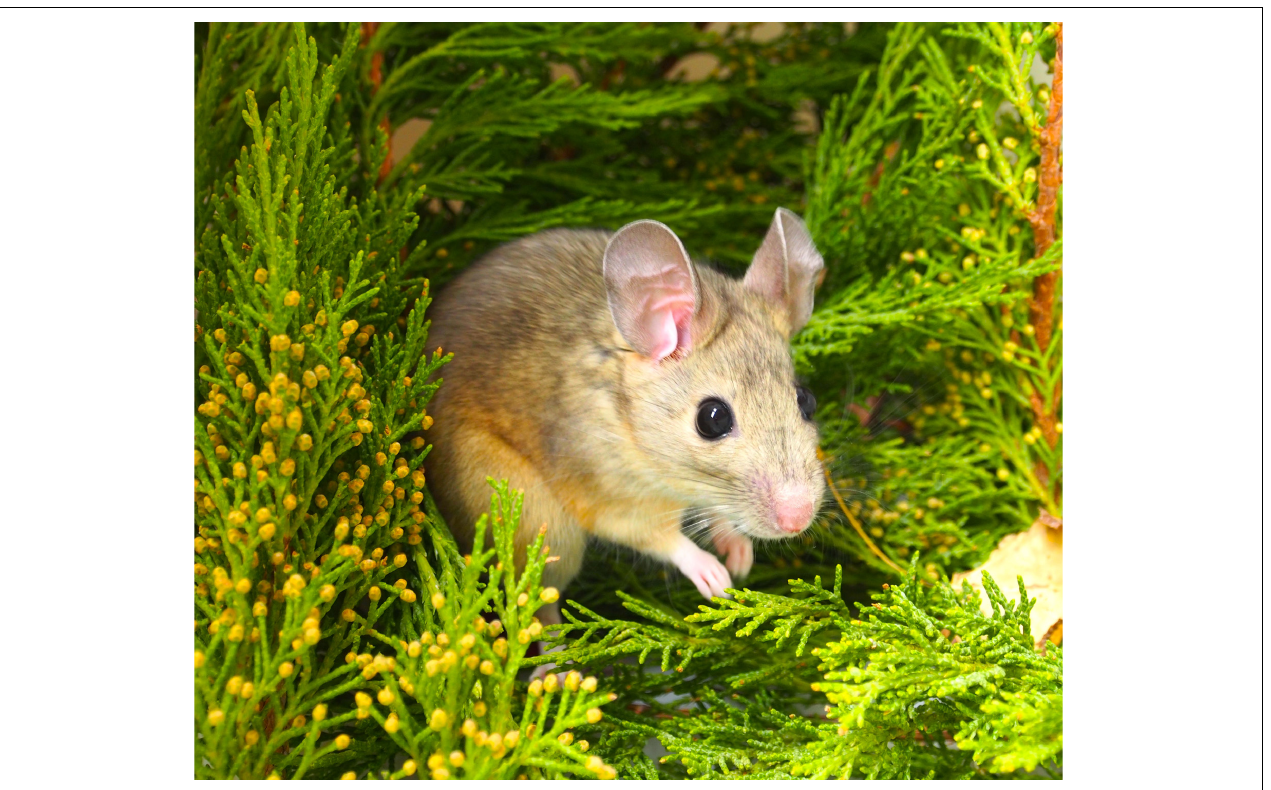
FIGURE 1 | A desert woodrat ( Neotoma lepida ) surrounded by terpene-rich